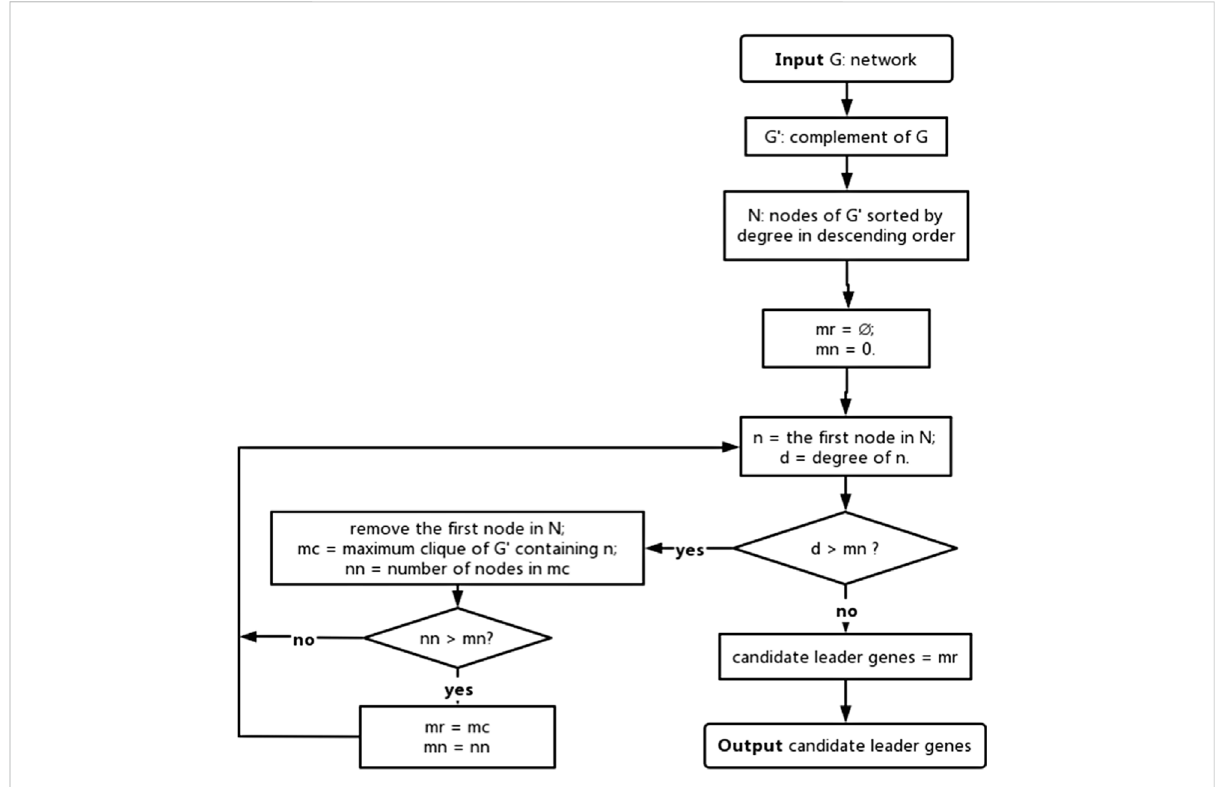
FIGURE 2 Graph theory-based algorithm for candidate leader gene